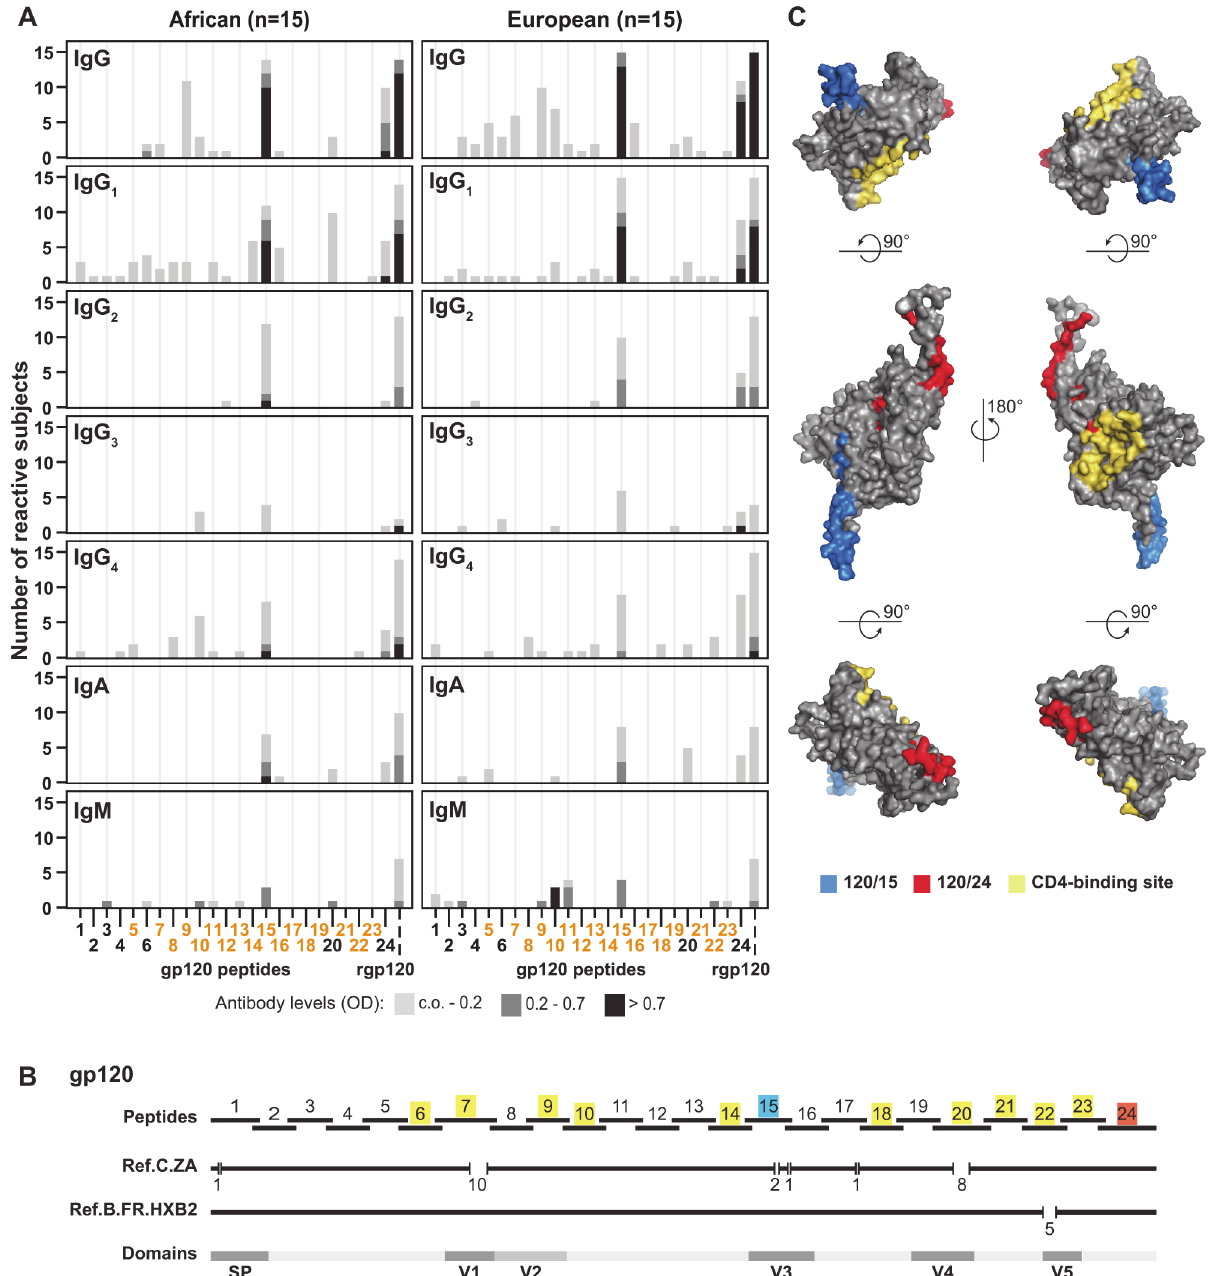
Fig 1. Antibody responses to HIV-1 clade C gp120 and gp120-derived peptides. (A) Frequencies and intensities (y-axes: number of reactive sera; OD levels color-coded) of IgG, IgG subclass, IgA and IgM responses of African (left) and European (right) patients to recombinant gp120 (rgp120) and 24 overlapping gp120 peptides (x-axes: peptides 1 – 24, peptides with predicted N-linked glycosylation sites: orange). (B) Position of overlapping gp120 peptides in gp120 of the HIV-1 clade C South African strain (Ref.C.ZA) and of the reference strain HXB2 (Ref.B.FR.HXB2). Gaps (numbers of missing amino acids are displayed) in gp120 from clade C and B required for optimal sequence alignment are indicated. Relevant protein domains described for gp120 clade B are indicated (SP, signal peptide; V1-V5, variable regions 1 – 5). Major IgG-reactive peptides 120/15 and 120/24 are indicated in blue and red, respectively and peptides containing amino acids involved in CD4 binding are shown in yellow. (C) Surface representation of the structural model of HIV-1 clade C gp120. Major antibody-reactive gp120 peptides (120/15: blue; 120/24: red) and amino acids involved in CD4 binding (yellow) are highlighted on different views of the model.